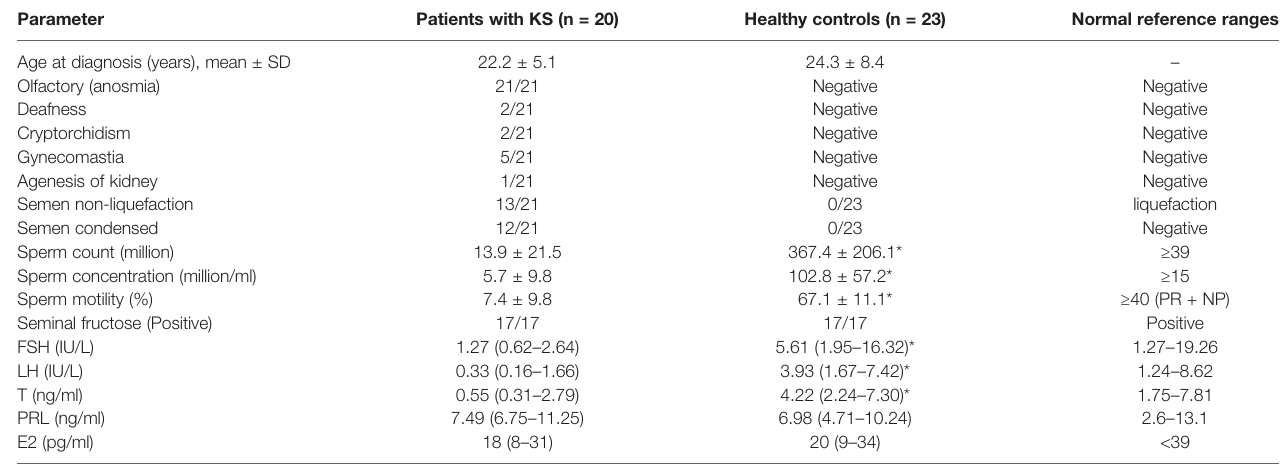
TABLE 1 | Clinical characteristics of all